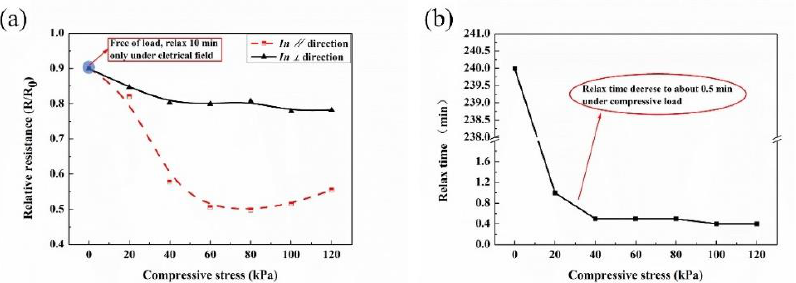
Figure 5. Static piezoresistivity of the printed composites under compressive stress and a test voltage of 0.56 V. ( a ) Resistance response to compressive load, and ( b ) relax time of the composites, referring to the time of the resistance reaches to a stable value.